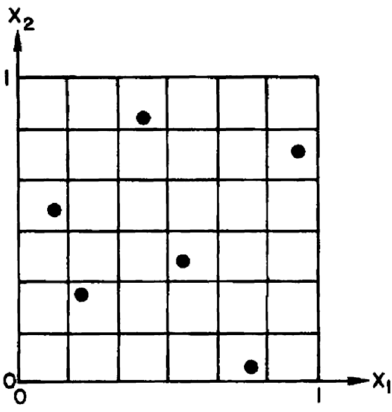
Figure 12. A schematic of six sample points selection using LHS method.